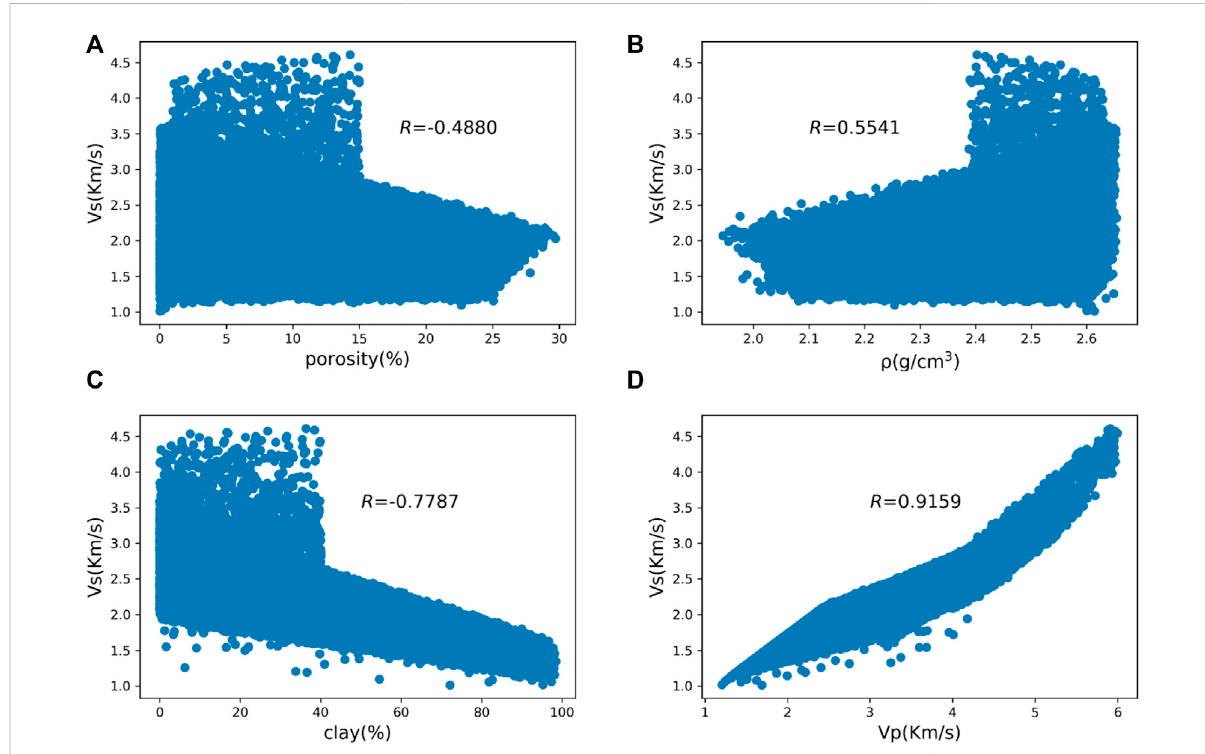
FIGURE 1 Correlation betweenreservoir parametersand S-wave velocity. (A) Porosity versusS-wave velocity. (B) Density versus S-wave velocity. (C) Clay content versus S-wave velocity. (D) P-wave velocity versus S-wave velocity.